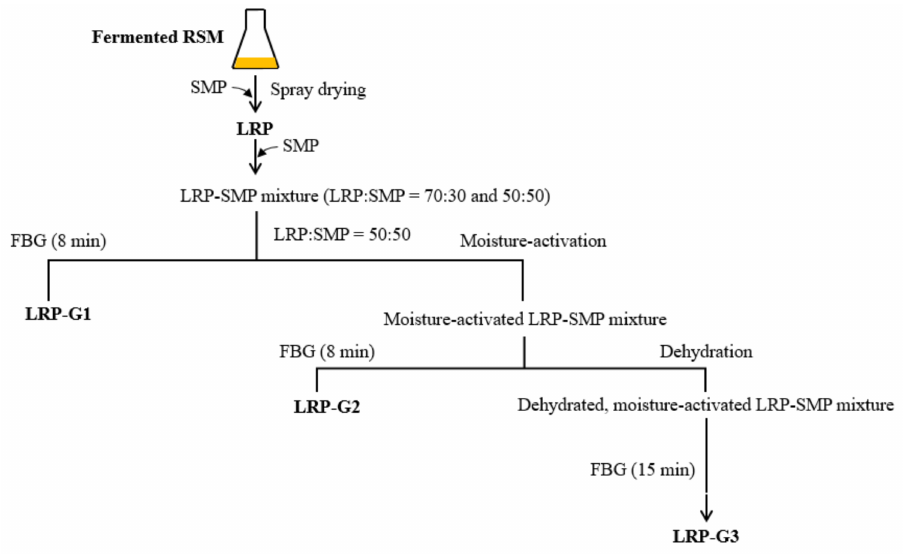
Figure 1. Experimental scheme. RSM, reconstituted skim milk; SMP, skim milk powder; FBG, fluidized bed granulation; LRP, LGG-fermented RSM powder; LRP-G1, granules obtained by FBG of LRP-SMP mixture (50:50); LRP-G2, granules obtained by FBG of moisture-activated LRP-SMP mixture (50:50); LRP-G3, granules obtained by FBG of moisture-activated, dehydrated LRP-SMP mixture